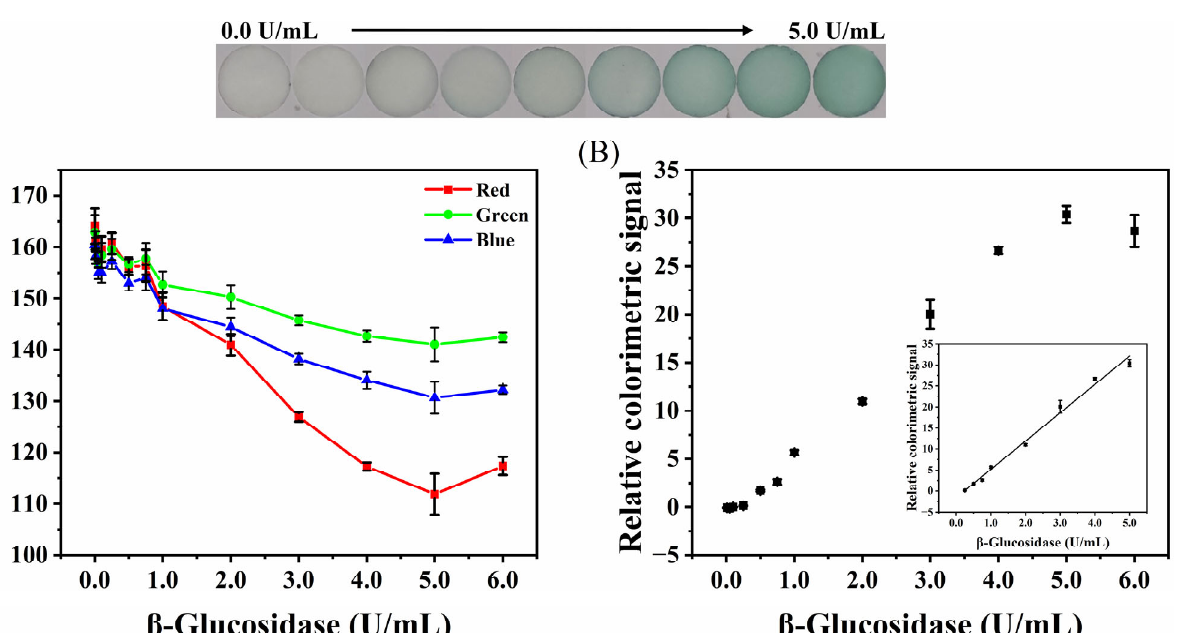
Table 1. Comparison of detection methods for β